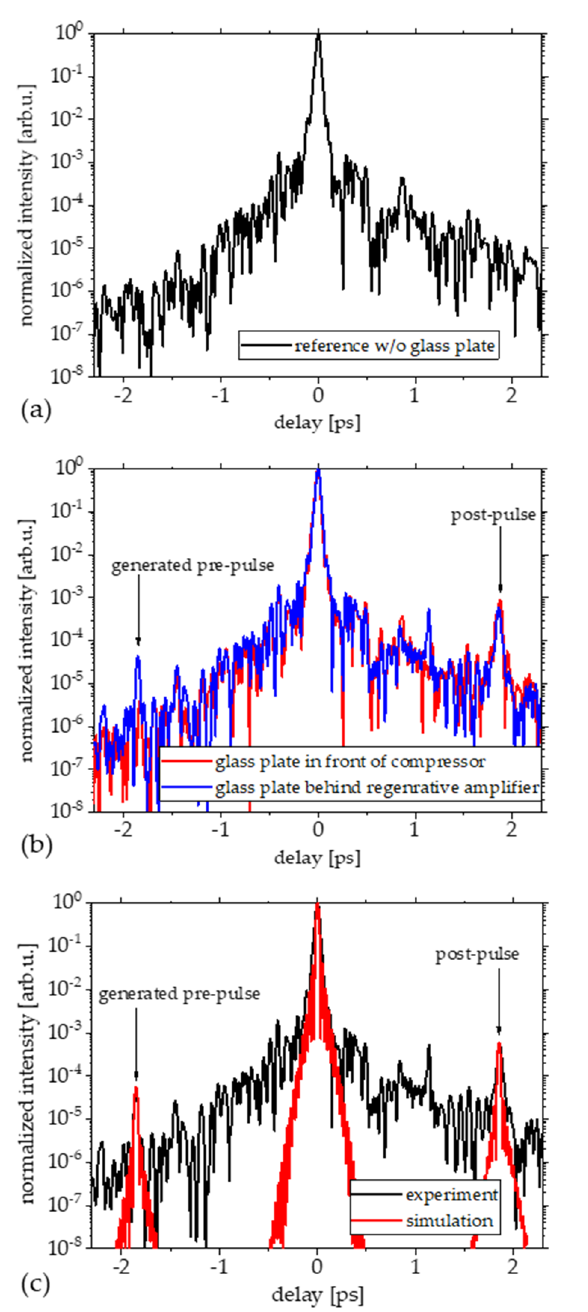
Figure 4. Measurement of non-linear pulse coupling with SRSI-ETE. The shown contrast traces are derived from the squared AC line of the Fourier transformed interferogram; ( a ) shows the reference measurement without any glass plate. ( b ) shows the measurement if the glass plate is inserted behind compression (position 2 in Figure 1) and the measurement with pulse coupling if the glass plate is applied in front of the regenerative amplifier (position 1 in Figure 1). ( c ) shows the measured trace for pulse coupling together with the matched calculation leading to a B-integral value of 0.41.